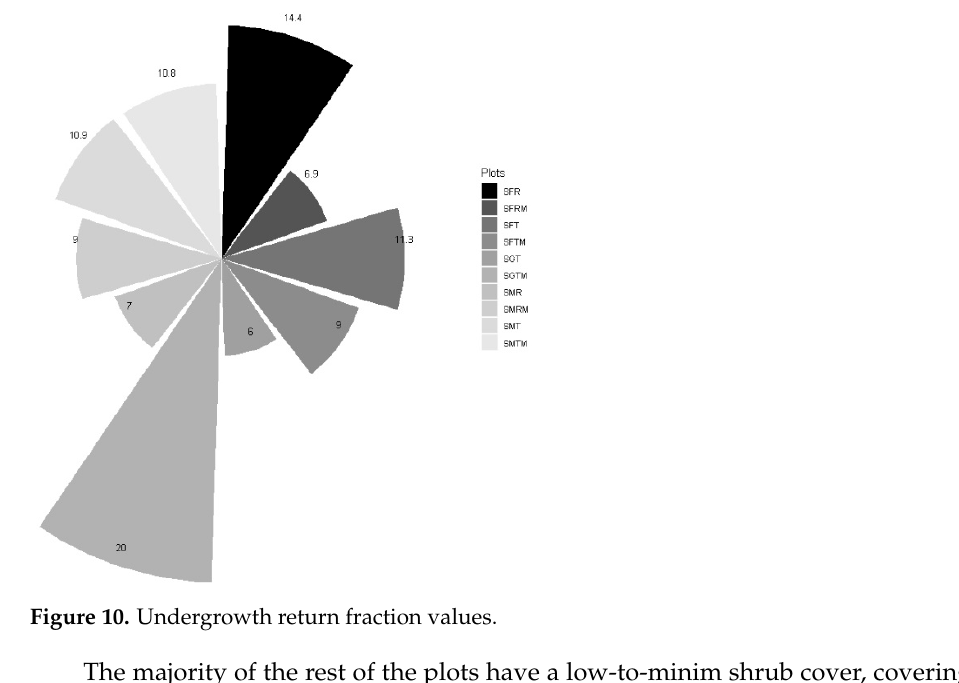
Figure 9. Mapping of the shrub layer (5 × 5 m pixel)—undergrowth return fraction.